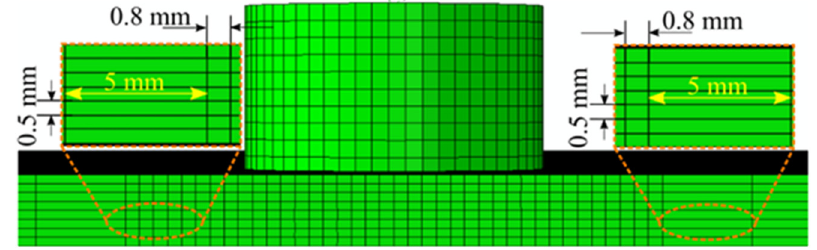
Figure 2. User-defined mesh of the computational domain. Table 4. The Johnson–Cook material model for AA6061 and AZ31B [26,27]. Materials